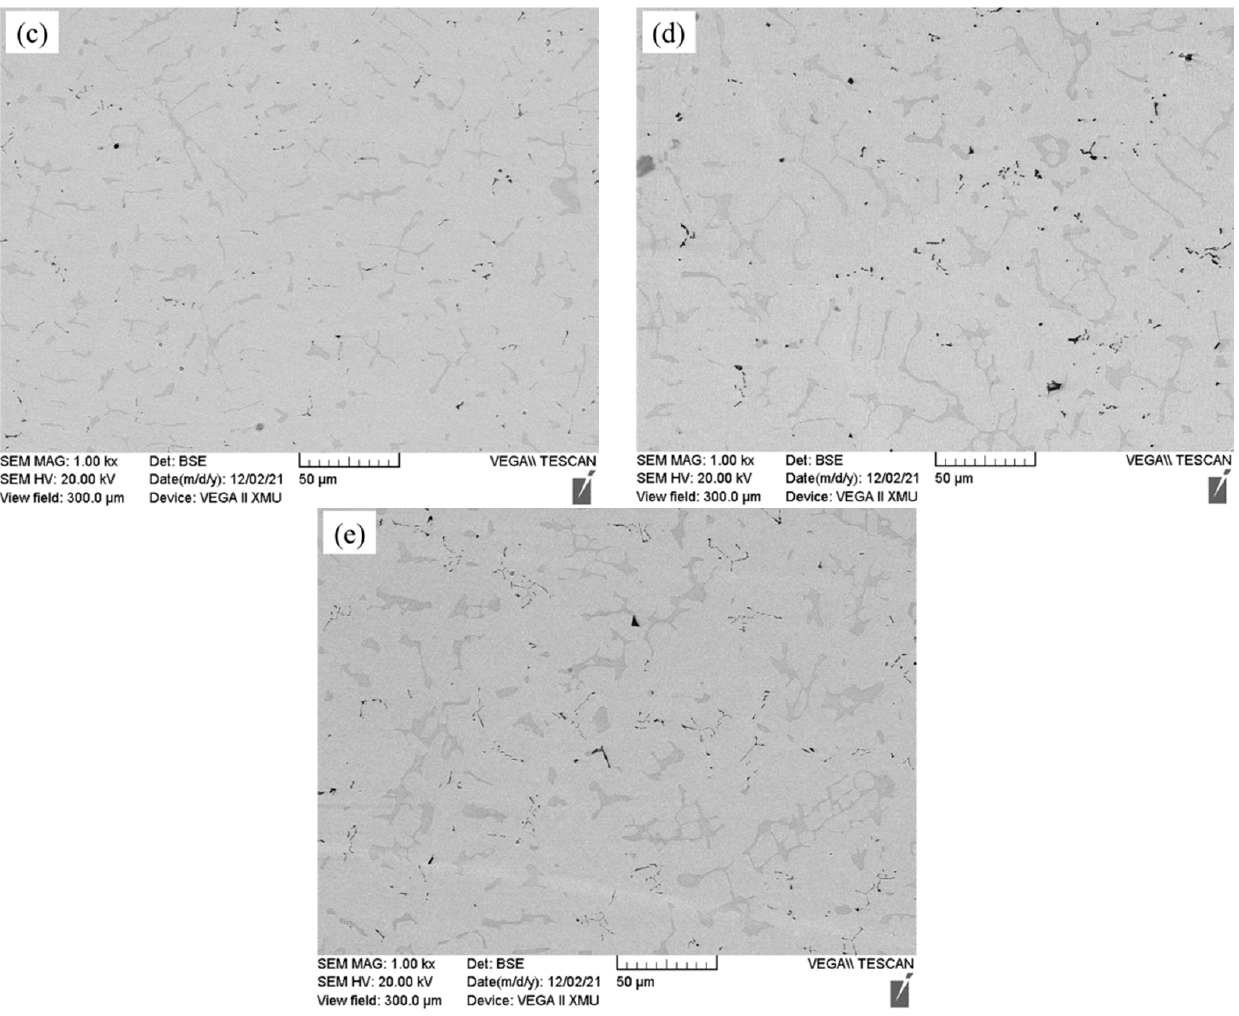
Figure 8. The micrograph for the surface morphology of Fe-25Mn-9Al-8Ni-1C-xTi alloy before the oxidation. ( a ) 0 wt.% Ti; ( b ) 0.1 wt.% Ti; ( c ) 0.2 wt.% Ti; ( d ) 0.3 wt.% Ti; ( e ) 0.4 wt.% Ti.